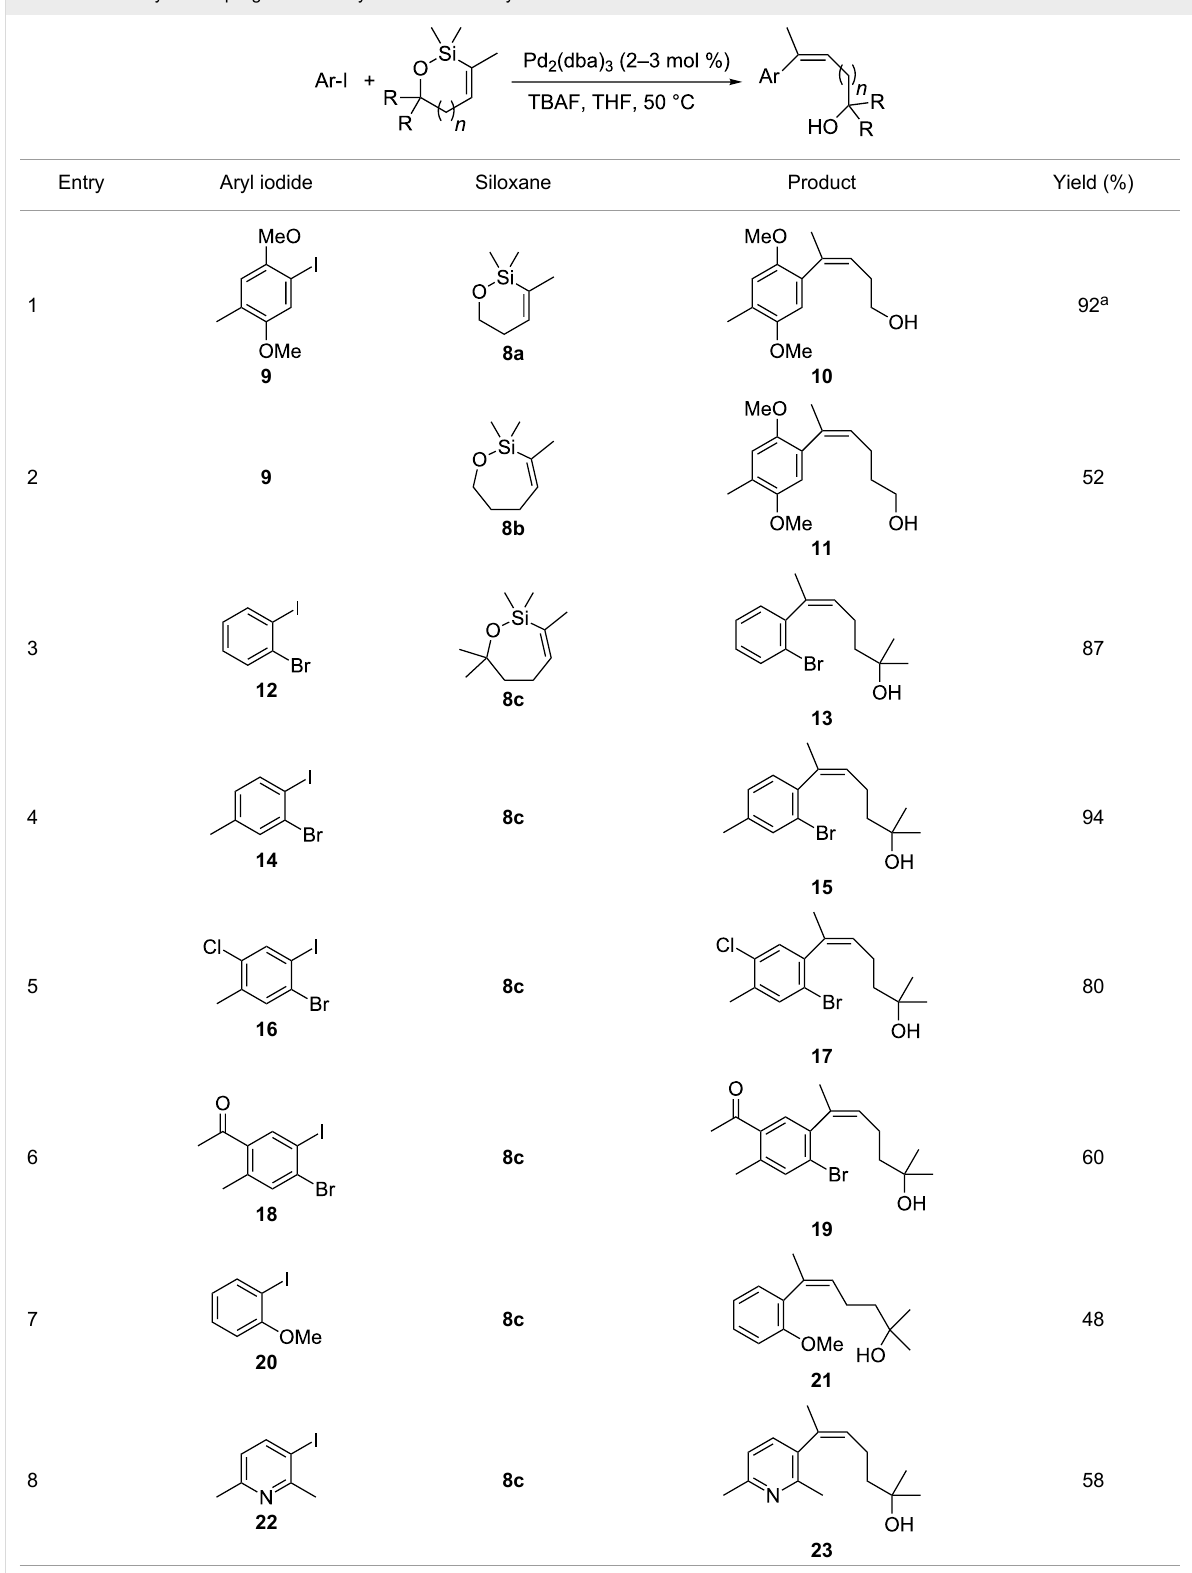
Table 1: Pd-catalyzed couplings of oxasilacycloalkenes with aryl